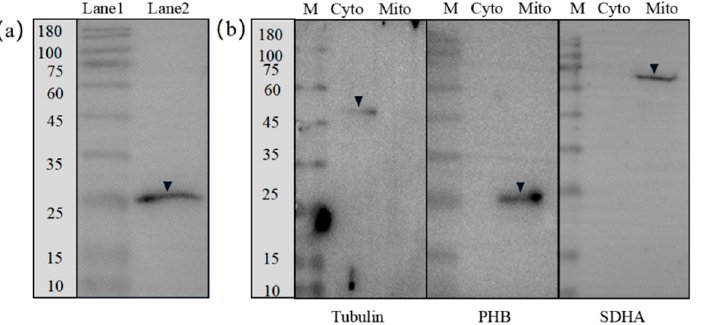
Figure 8. Western blotting images demonstrating Ob -PHB present in the mitochondria. ( a ) Western blotting images demonstrating the specificity of anti-PHB antibodies. Lane 1: protein marker; Lane 2: PHB protein. ( b ) Intracellular location of Ob -PHB in stage IV testes. SDHA was detected in Mito and β -tubulin was detected in Cyto. PHB was detected in Mito, confirming that it was located in the mitochondria. M: protein marker; Mito: mitochondrial protein fraction purified from the stage IV testis; Cyto: total protein extracted from the cytoplasmic fraction.